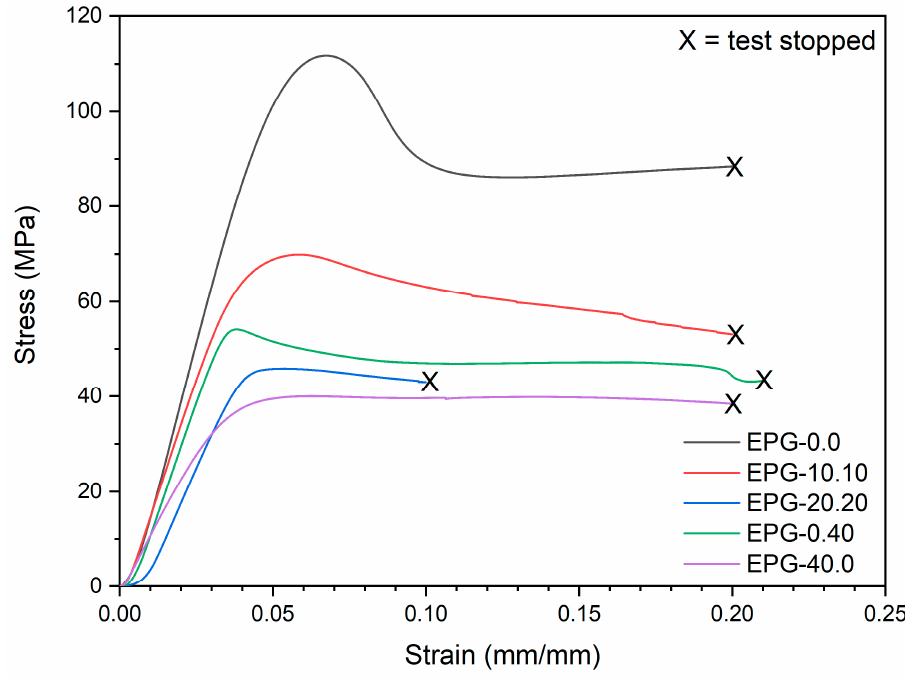
Figure 4. Representative stress–strain curves from quasi-static compressive tests on the prepared syntactic foams.